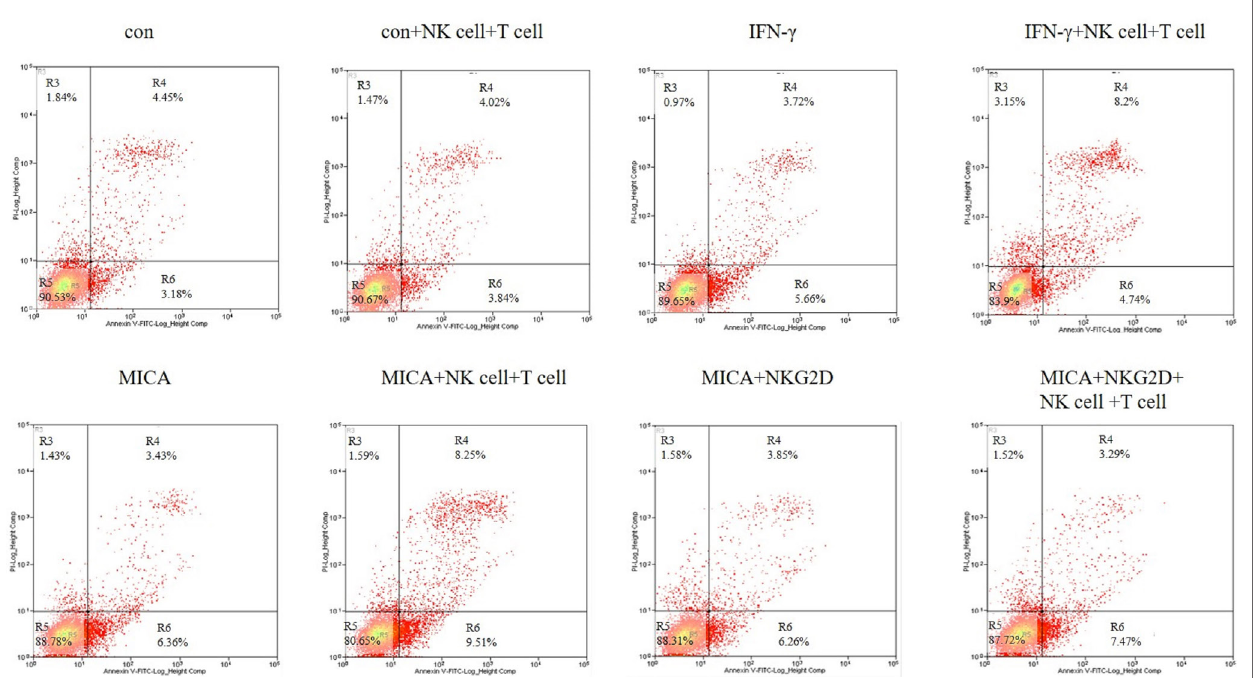
FigUre 8 | Effect of IFN- γ treatment and MICA plasmid transfected on human corneal epithelial cells apoptosis in terms of Annexin-V/PI staining. Numbers represent the percentage of cells in each